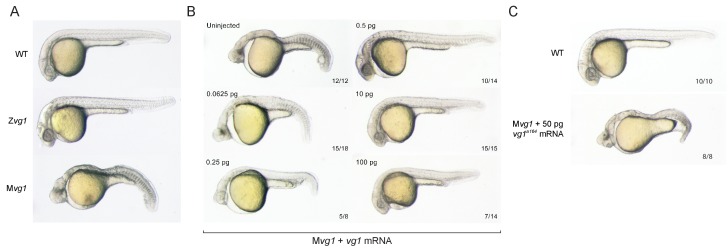
Maternal vg1 is required for mesendoderm formation.(A) Zygotic and maternal vg1 (Zvg1 and Mvg1) mutants and wild-type (WT) embryo at 28 hours post-fertilization (hpf). See Figure 1—figure supplement 1 for information about the vg1 mutant alleles, and Figure 1—figure supplement 2 for analysis of left-right asymmetry in WT and Zvg1 embryos. (B) Mvg1 embryos injected with 0.0625–100 pg of vg1 mRNA. (C) Mvg1 embryo injected with 50 pg of vg1 mRNA containing the 8 bp deletion found in the genetic mutants (vg1a164).